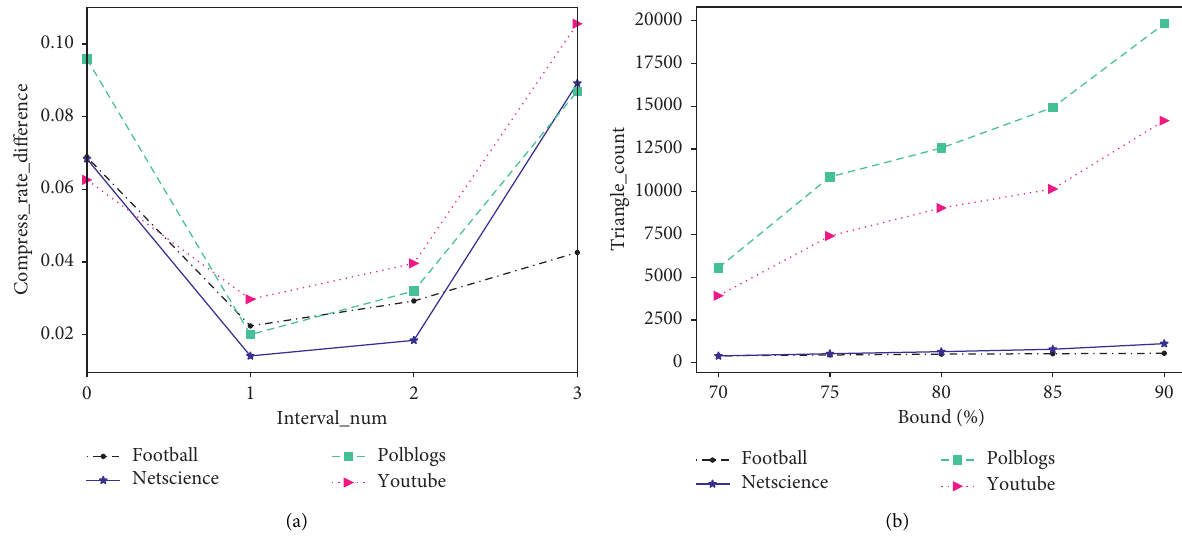
Figure 7: High-importance node selection criteria impact. (a) The difference of compression rate. (b) Number of triangle-subgraphs.